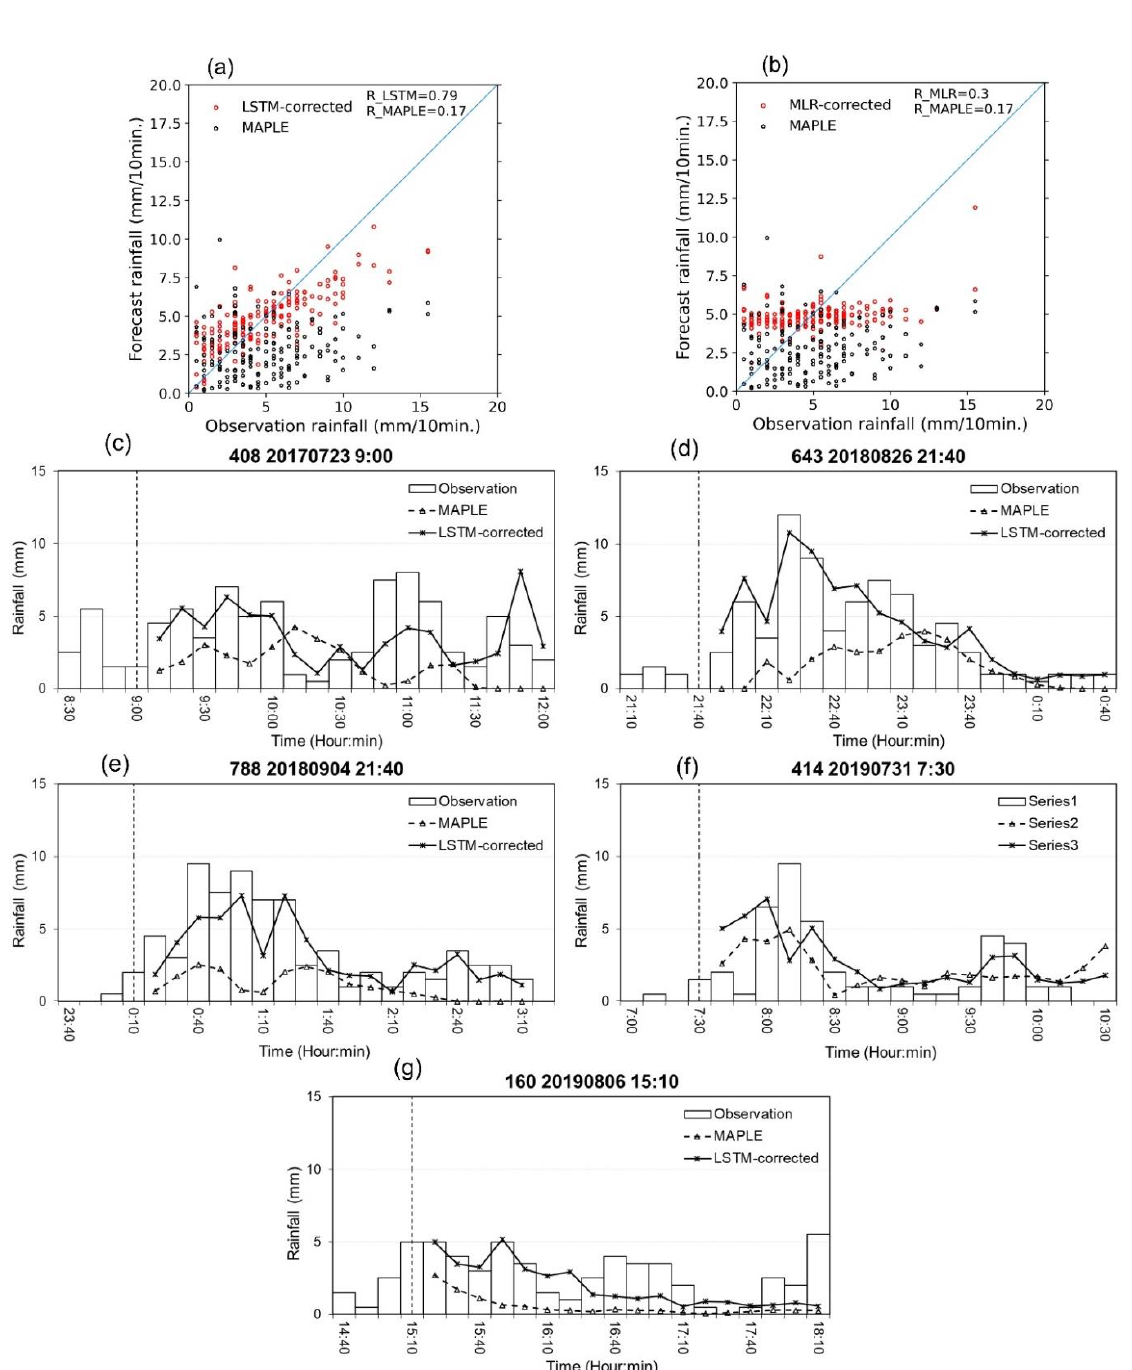
Figure 11. Scatter plot of MAPLE and LSTM-corrected rainfall ( a ) and MLR-corrected rainfall ( b ) in 60 min forecast time in the five test events (R_LSTM, R_MLR, and R_MAPLE are correlation coefficients of the LSTM, MLR, and MAPLE forecast rainfall, respectively). The rainfall time series regarding observation of rain gauges, MAPLE rainfall, and LSTM-corrected rainfall, for some stations in the events: ( c ) 20170723, ( d ) 20180826, ( e ) 20180904, ( f ) 20190731, and ( g ) 20190806. The vertical dashed lines represent the initial time step (t 0 ) of the forecast generated in the events.